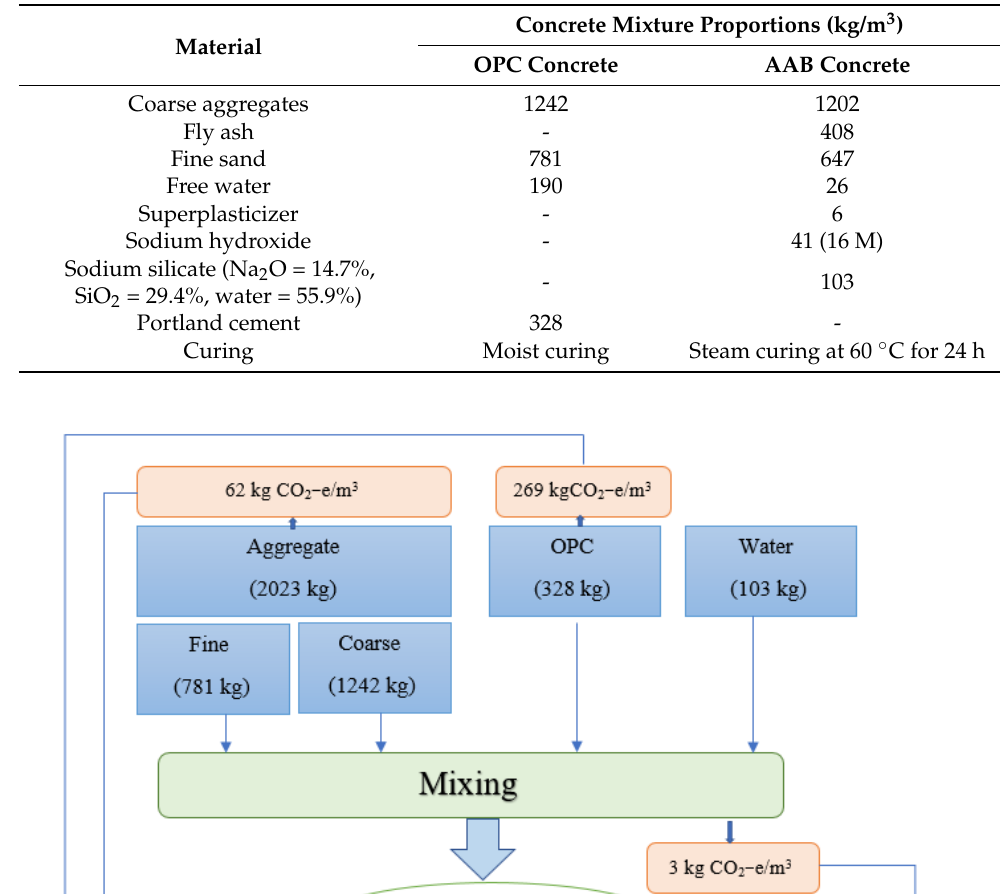
Figure 8. Life cycle stages for alkali-activated binder (geopolymer) concrete.